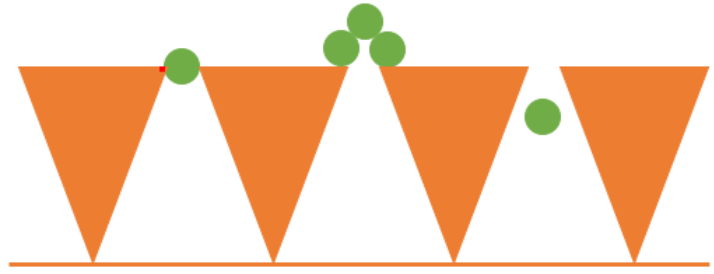
Figure 10. Wedge/Triangular wire profile and its interaction with particles.